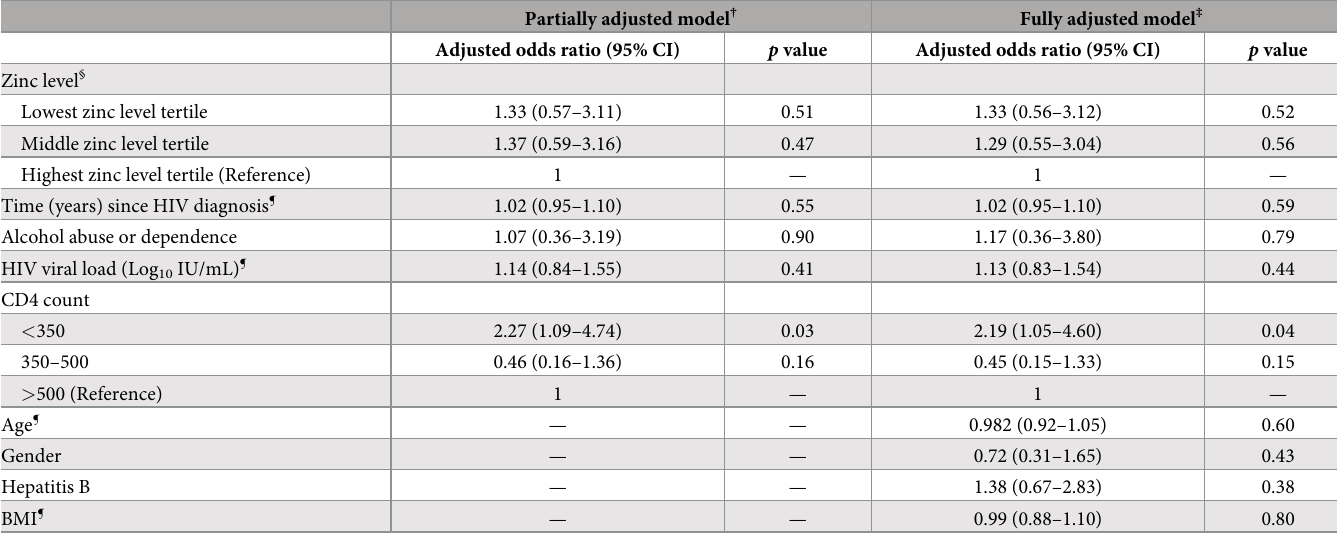
Table 3. Association between zinc tertile level and advanced liver fibrosis, logistic regression